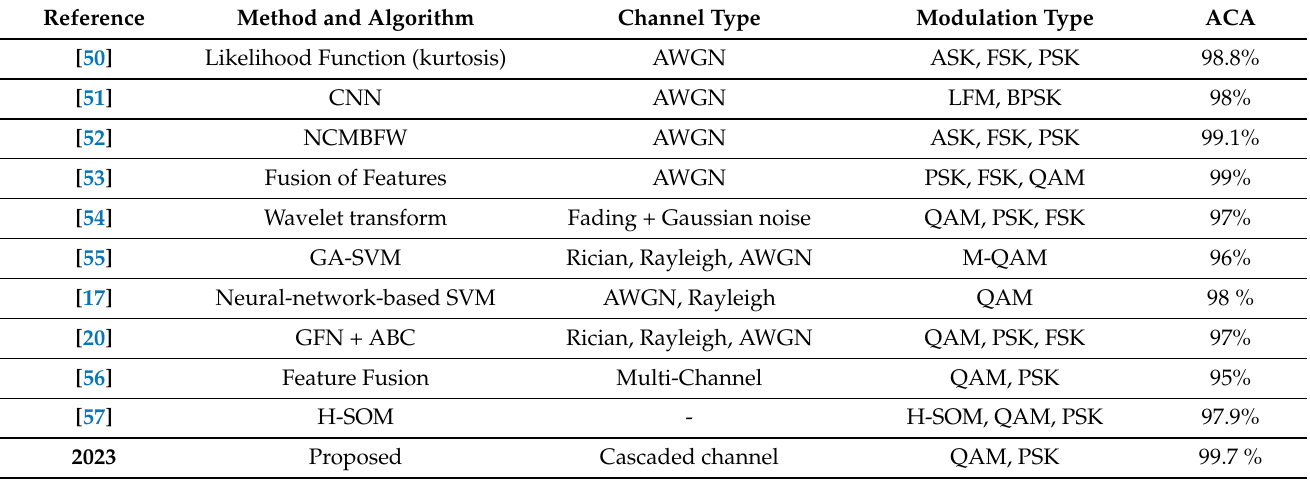
Table 5. Comparison with existing